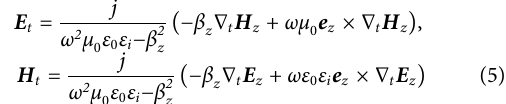
of the myelin sheath region. The transverse fi eld components are